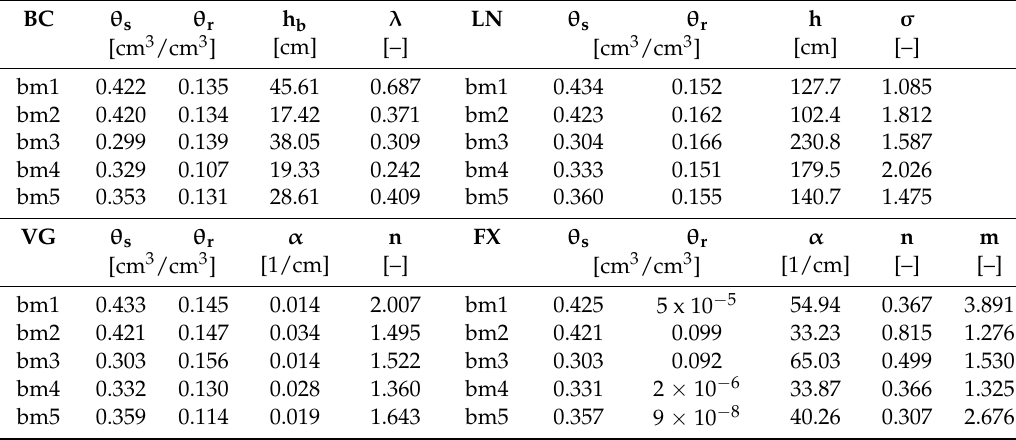
Table 4. Fitted soil water retention curve parameters of the boulder marl (bm): Brooks–Corey (BC) model [18], van Genuchten (VG) model [9], Fredlund and Xing (FX) model [19], Kosugi (LN) model